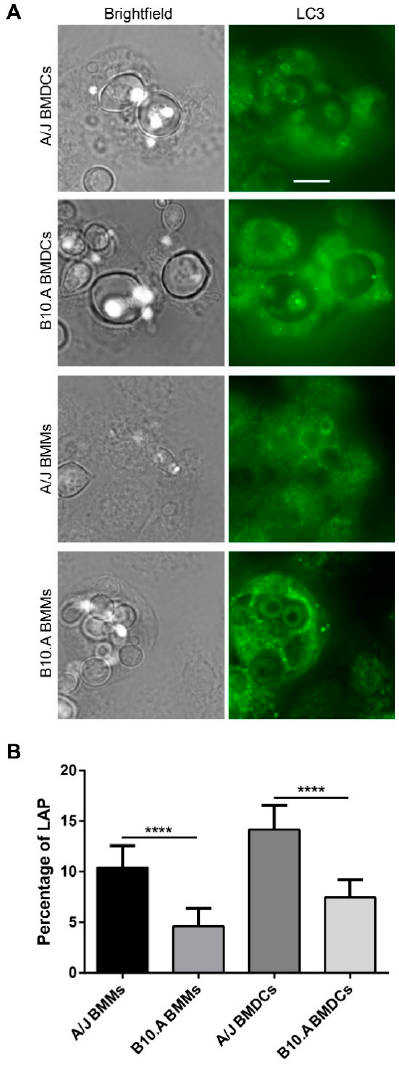
Figure 7. Light chain 3 (LC3)-associated phagocytosis of bone marrow-derived macrophages (BMMs) and BMDCs from A/J and B10.A mice upon P . brasiliensis infection. BMMs and BMDCs were cocultured with P. brasiliensis at a multiplicity of infection (MOI) 1:1 for 12 h and treated with anti-LC3 fluorescent antibody. ( A ) The localization of LC3-associated phagocytosis (LAP) was assessed by fluorescence microscopy. The fluorescence images were processed by deconvolution using a constrained iterative algorithm. The arrows point to cells that are surrounded by the autophagosome marker LC3. Scale bar: 10 µm. ( B ) The percentage of LC3-associated phagocytosis (LAP) was measured by the number of phagocytosed fungal cells positive for LC3 divided by the total number of phagocytosed fungal cells. Data are presented as mean ± 95% C.I. ( n = 3 independent experiments, **** p < 0.0001 using Fisher’s exact test).